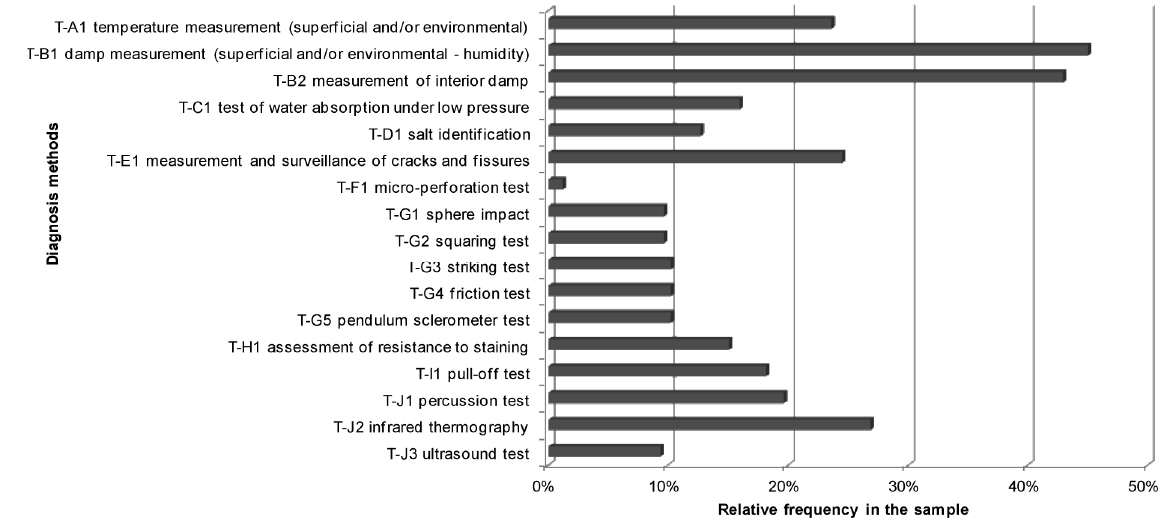
Fig. 12. Relative frequency of the diagnosis